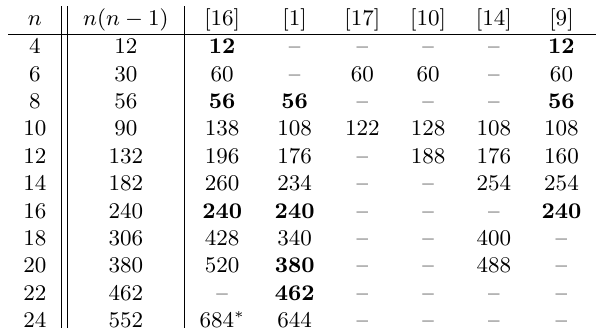
Table 5: Best upper bounds on Γ( n ) found for round-robin tournaments of even orders n by various authors (references are given in chronological order). Cases for which the lower bound